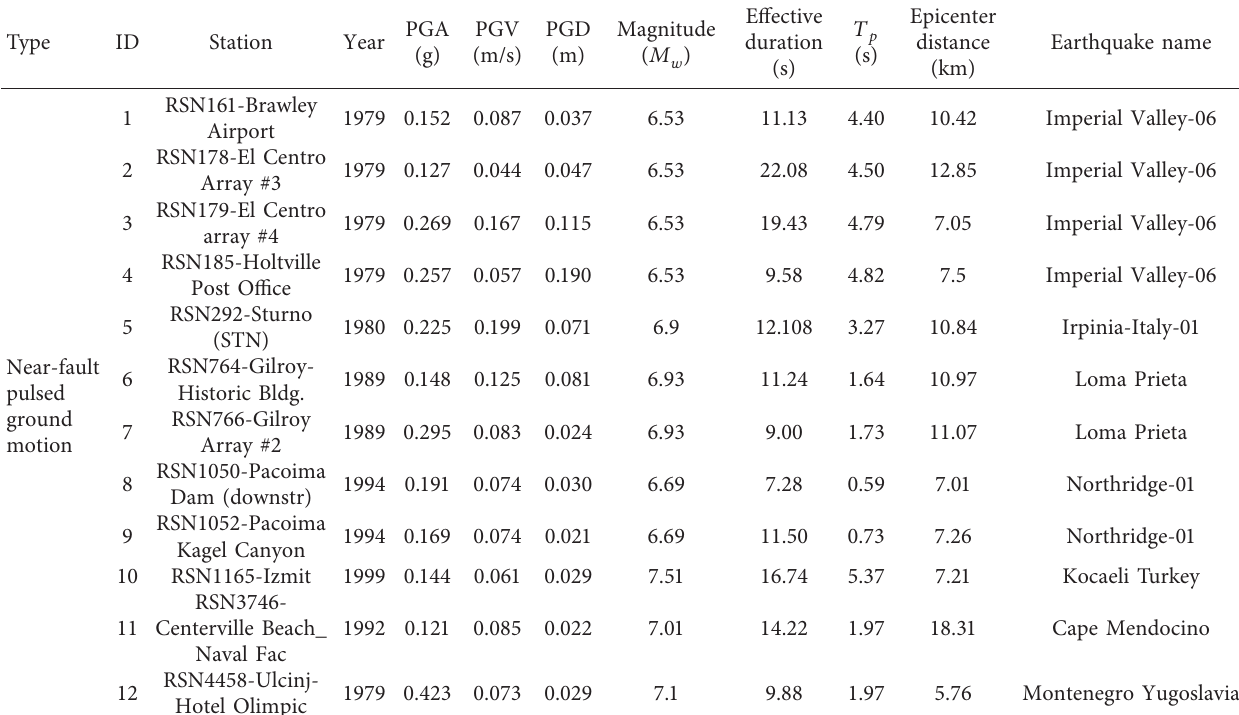
Table 3: The specific information about the selected ground motion